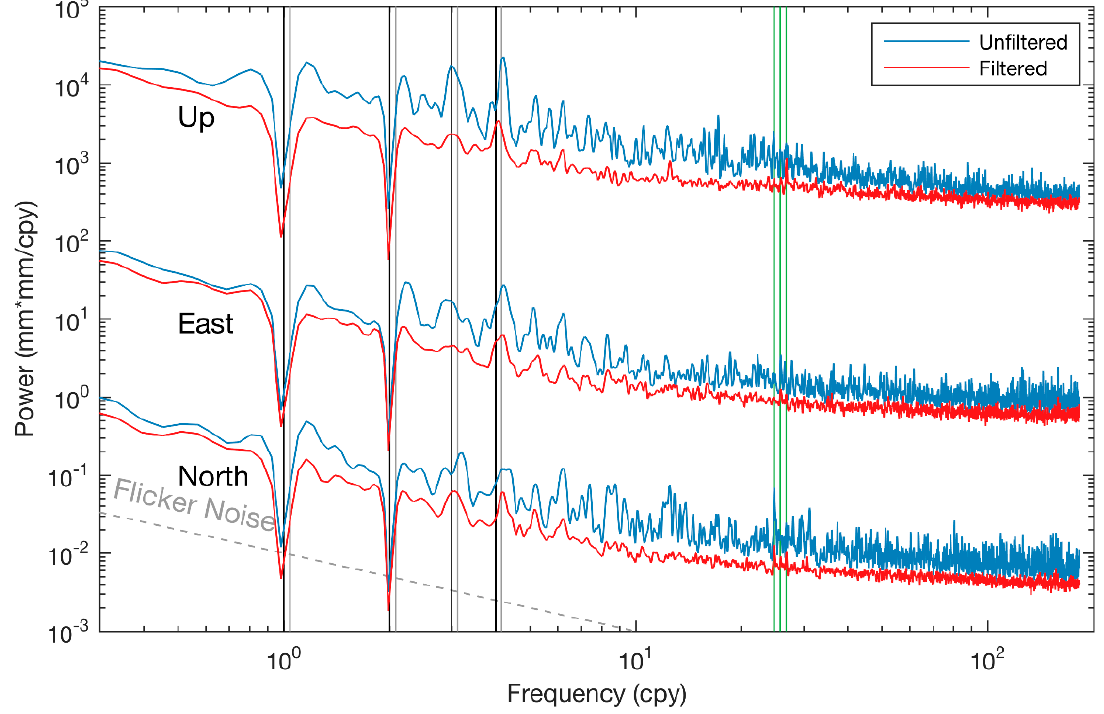
Figure 9. Same as Figure 7, but for the CMONOC-II time series.